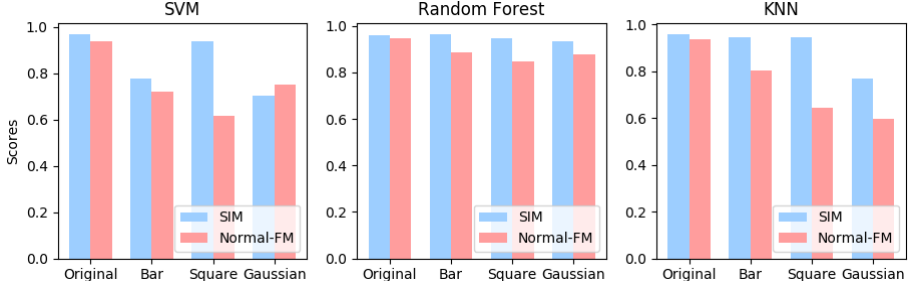
Fig. 8. (Color online) Comparison of classi¯cation accuracy between SIM images and normal °uorescence microscopy (Normal- FM) images.